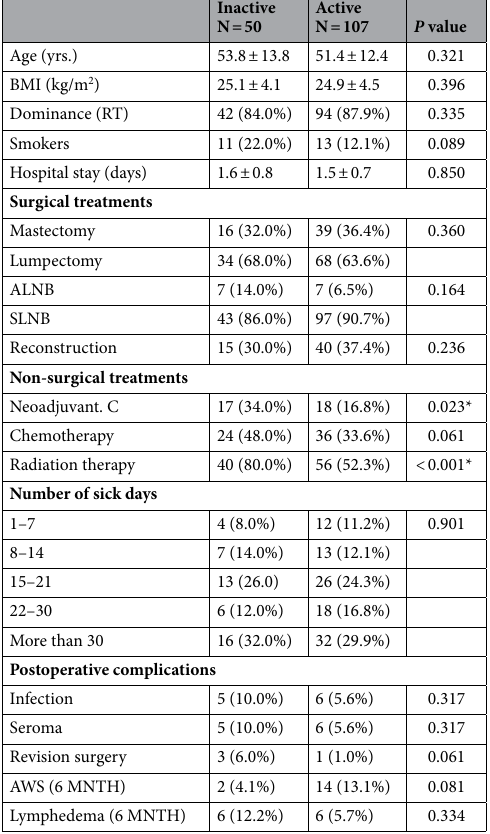
Table 1. Baseline characteristics of the study population. Continuous variables are presented as mean and standard deviation (SD) and categorical variables are presented as number and percentage. Significant p value* p ≤ 0.05. YRS, Years; BMI, Body mass index; kg/m 2 , Mass in kilograms divided by the square of the body height in meters; RT, Right; Neoadjuvant. C, Neoadjuvant Chemotherapy; ALND, Axillar lymph node dissection; SLNB, Sentinel lymph node biopsy; BRCA1-2, Breast Cancer gene; NPRS, Numeric pain rating scale; AWS, Axillar web syndrome; MNTH,